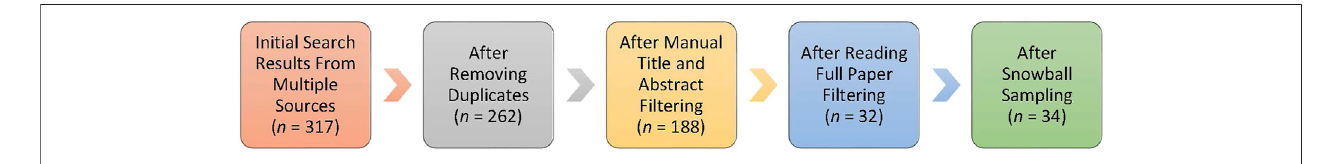
FIGURE 3 | Number of articles included in the review after various stages of fi